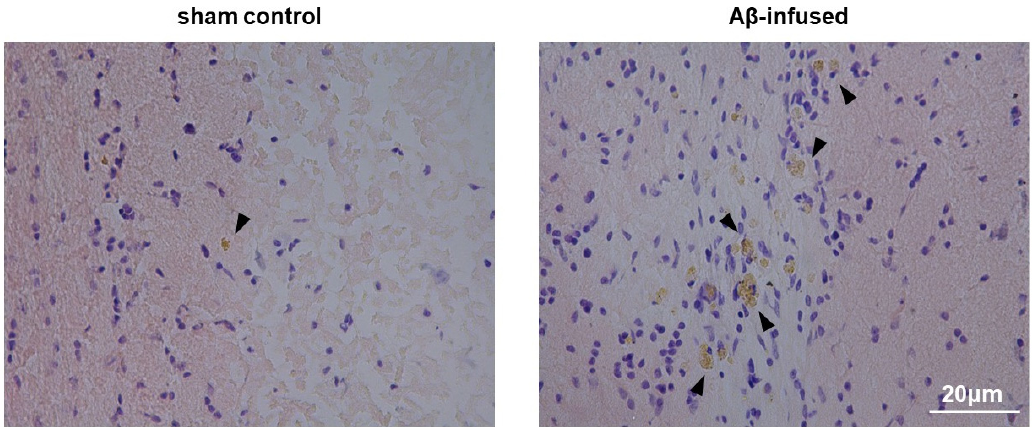
Figure 1. Representative images of hippocampus sections stained with Congo red in sham control and A β (1–42) -infused rat model. Extracellular A β deposits were visualized in brownish color and indicated by arrows; the nuclei were counterstained with cresyl violet (purple). Pictures were taken at the magnification of ×20. Scale bar: 20 μ m.